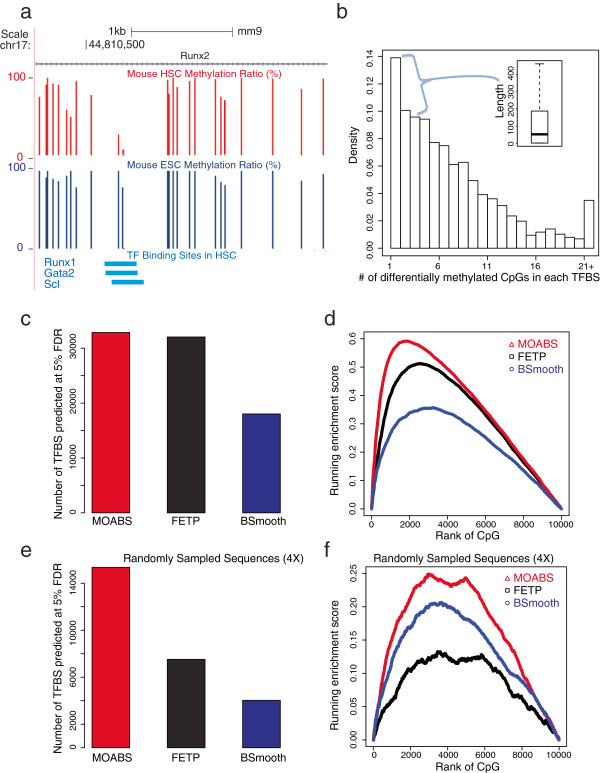
MOABS reveals differential methylation underlying TFBSs. (a) UCSC genome browser illustration of one TF binding site. The tracks from top to bottom are genomic positions, RefSeq Gene, HSC Methylation, ESC Methylation, and TFBS. For each CpG, an upward bar denotes the methylation ratio. (b) Distribution of the number of DMCs underlying TFBSs. The inserted boxplot indicates the length distribution of TFBSs with 1–3 DMCs. (c) Number of differentially methylated TFBSs predicted by different methods at 5% FDR. (d) Running enrichment scores for TFBSs. All the CpGs are ranked by each method. The score increases if the CpG is in a TFBS or decreases if not. Only 10000 CpGs are sampled to make this plot, as indicated by the x-axis. The 10000 times of random shuffle of TFBSs determined p-values of the maximum enrichment score to be 1.4E-3, 1.6E-3, and 4E-3 for MOABS, FETP and BSMOOTH respectively. (e) and (f) Same as (c) and (d) with 4X sequencing depth by random sampling. The 10000 times of random shuffle of TFBSs determined p-values of the max enrichment score to be 2.9E-2, 5.1E-2, and 9.2E-2 for MOABS, FETP and BSMOOTH respectively.